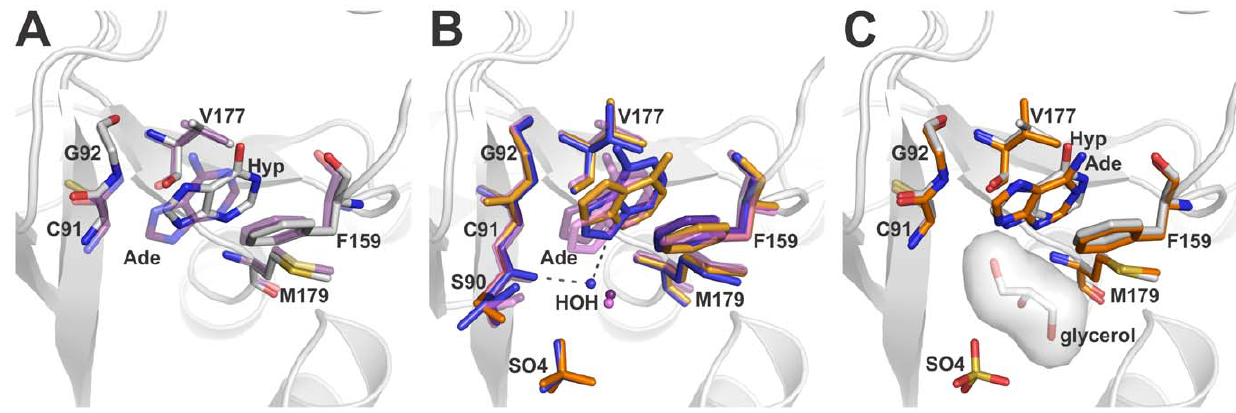
Figure 2. Comparison of free bases bound to the BsPNP233 active site. A. Structural comparison of a representative BsPNP233-Ade complex ( purple carbon atoms) with the BsPNP233-Hyp complex ( grey carbon atoms). B. The structure of the four BsPNP233-Ade complexes solved independently are superimposed. The sulfate-free Ade-complexes are colored in purple (chain A) and pink (chain B) whereas the two independent complexes solved with sulfate bound (dataset I) are colored in orange (chain A) and blue (chain B). C. The structure of the Ade-complex where Ade presents an alternative conformation (carbon atoms in orange ) is superimposed in the structure of Hyp-complex (carbon atoms in grey ). The surface of the glycerol molecule present at the Hyp-complex is shown to evidence the influence of this molecule in the position and orientation of Hyp in the active site. The hydrogen bonds are shown as dashed lines.